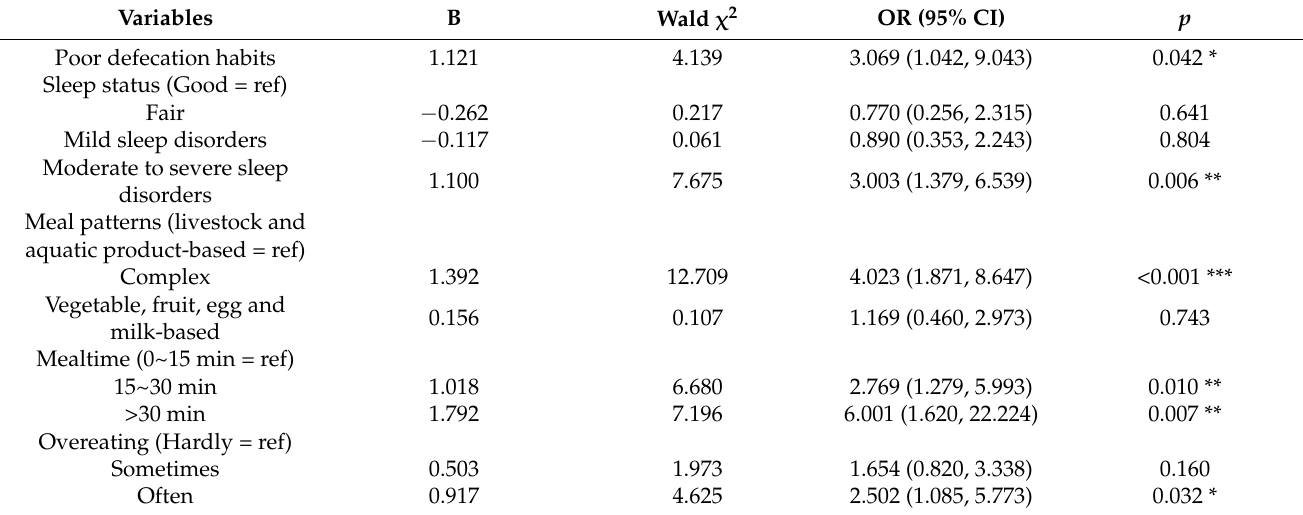
Table 5. A binary logistic regression analysis of factors associated with FC among university